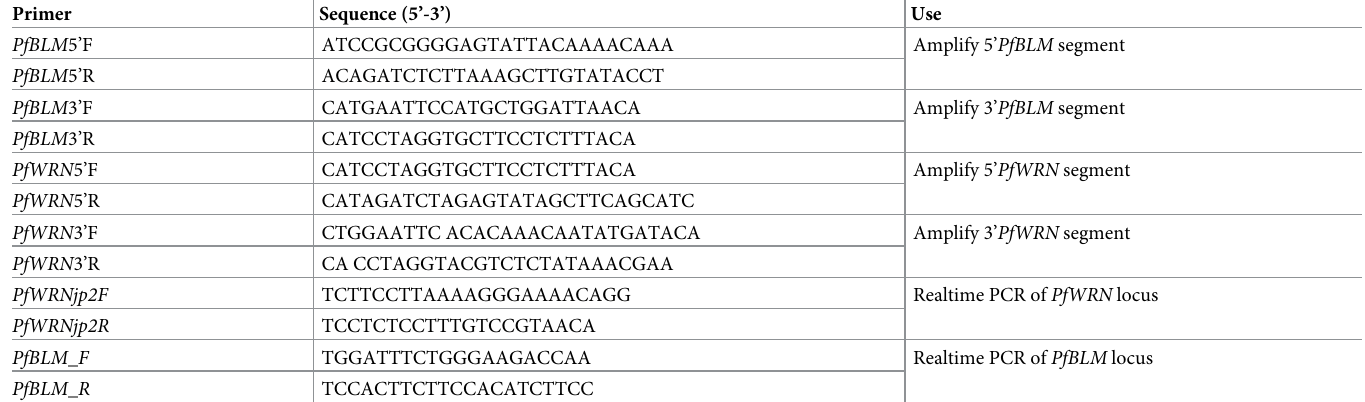
Table 3. Primers used in this study.